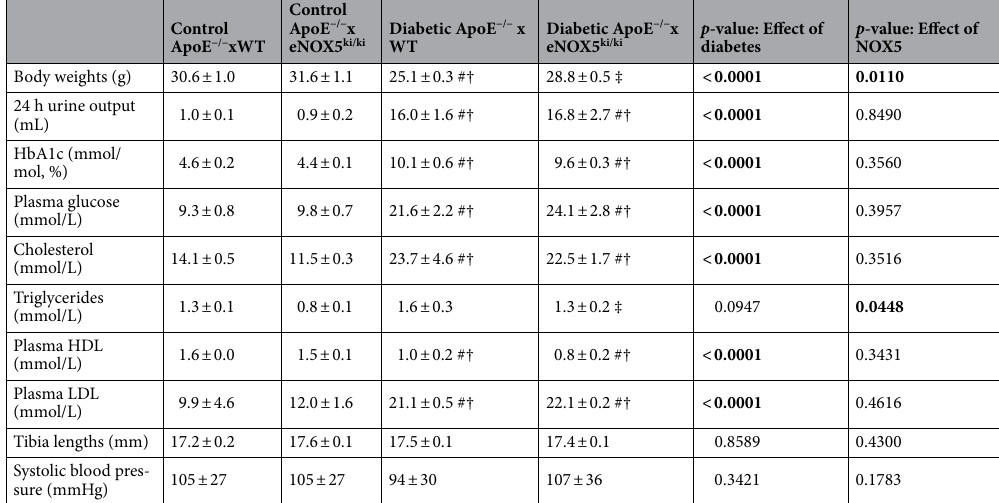
Table 2. Baseline data including metabolic parameters for animals at 20 weeks of study. Data shown as mean ± SEM. Two-way ANOVA statistics shown in columns. Post-hoc multiple comparisons test (Tukey’s): # versus Control ApoE −/− x WT group; † versus Control ApoE −/− x eNOX5 ki/ki group; ‡ versus Diabetic ApoE −/− x WT group. n = 6–10/group for body weight, 24 h urine output and HbA1c values; n = 7–9/group for plasma values; n = 8–18/group for tibia lengths; n = 9–15 for blood pressure measurements. The first p value “the effect of diabetes” is for the comparison between non-diabetic WT mice and diabetic WT mice. The second p value “the effect of NOX5” is for the comparison between diabetic WT mice and diabetic NOX5 mice. ApoE −/− = Apolipoprotein E knockout; HDL = high density lipoprotein; LDL = low density lipoprotein; NOX = NADPH oxidase. Significant values are